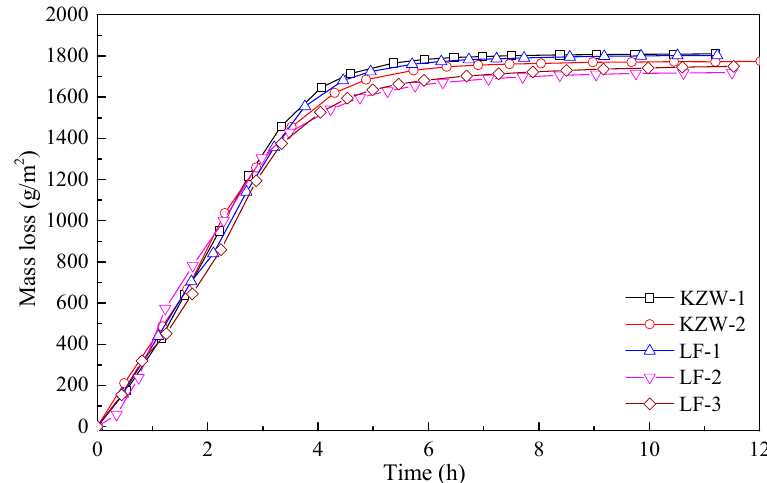
Figure 6. Drying process of different emulsions.